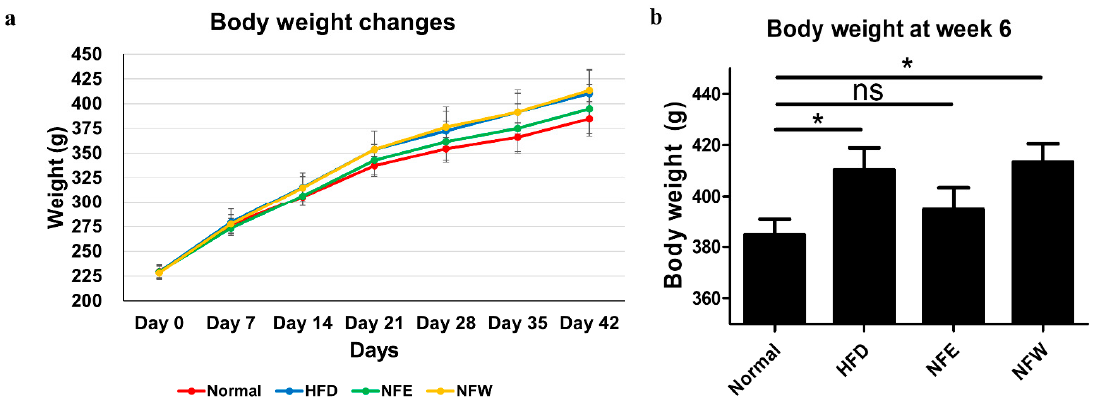
Figure 4. Body weight changes in the rat model induced by a high-fat diet. ( a ) Body weight changes over six weeks in four groups. ( b ) Body weight bar graph at week 6. The normal group had a regular chow diet. The HFD group had a high-fat diet. The NFE group had an ethanol extract with a high-fat diet. The NFW group had a water extract with a high-fat diet (*, p < 0.05; ns, not significant). The alpha diversity of the gut microbiota composition in a murine model was mea- sured using the Simpson index. As a result, the HFD group showed significantly lower enrichment than the normal group ( p = 0.0019). The NFE group showed a significantly higher diversity value in the Simpson index than the HFD group ( p = 0.021). The NFW group showed a significantly lower diversity value than the normal group ( p = 0.0006), and was lower than the HFD group, although the difference was not statistically significant ( p = 0.26) (Figure 5a). The beta diversity was measured based on PCoA plot using Bray–Curtis dissimilarity at the phylum and genus levels. At all levels, the rat stool samples of the four groups showed significant separation ( p < 0.001) (Figure 5b,c).